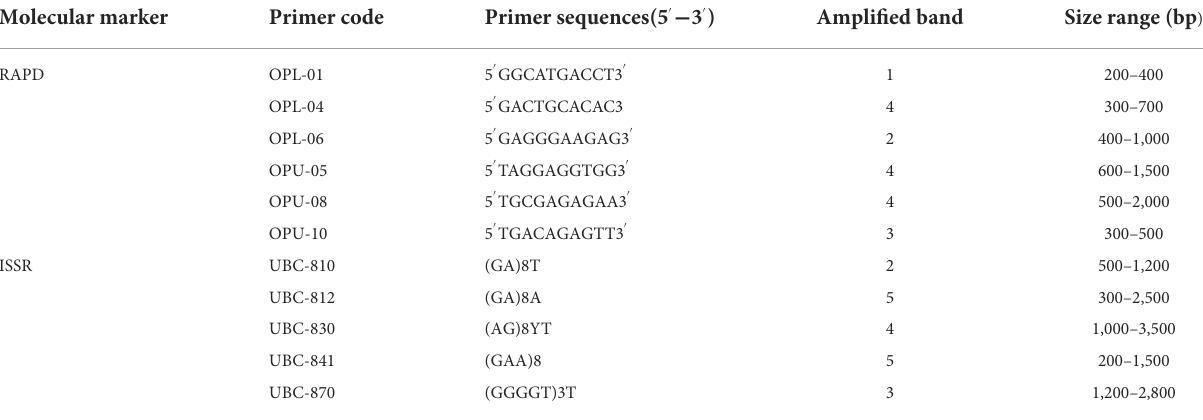
TABLE 8 List of RAPD and ISSR primers and their sequences along with scorable bands and size range. Molecular